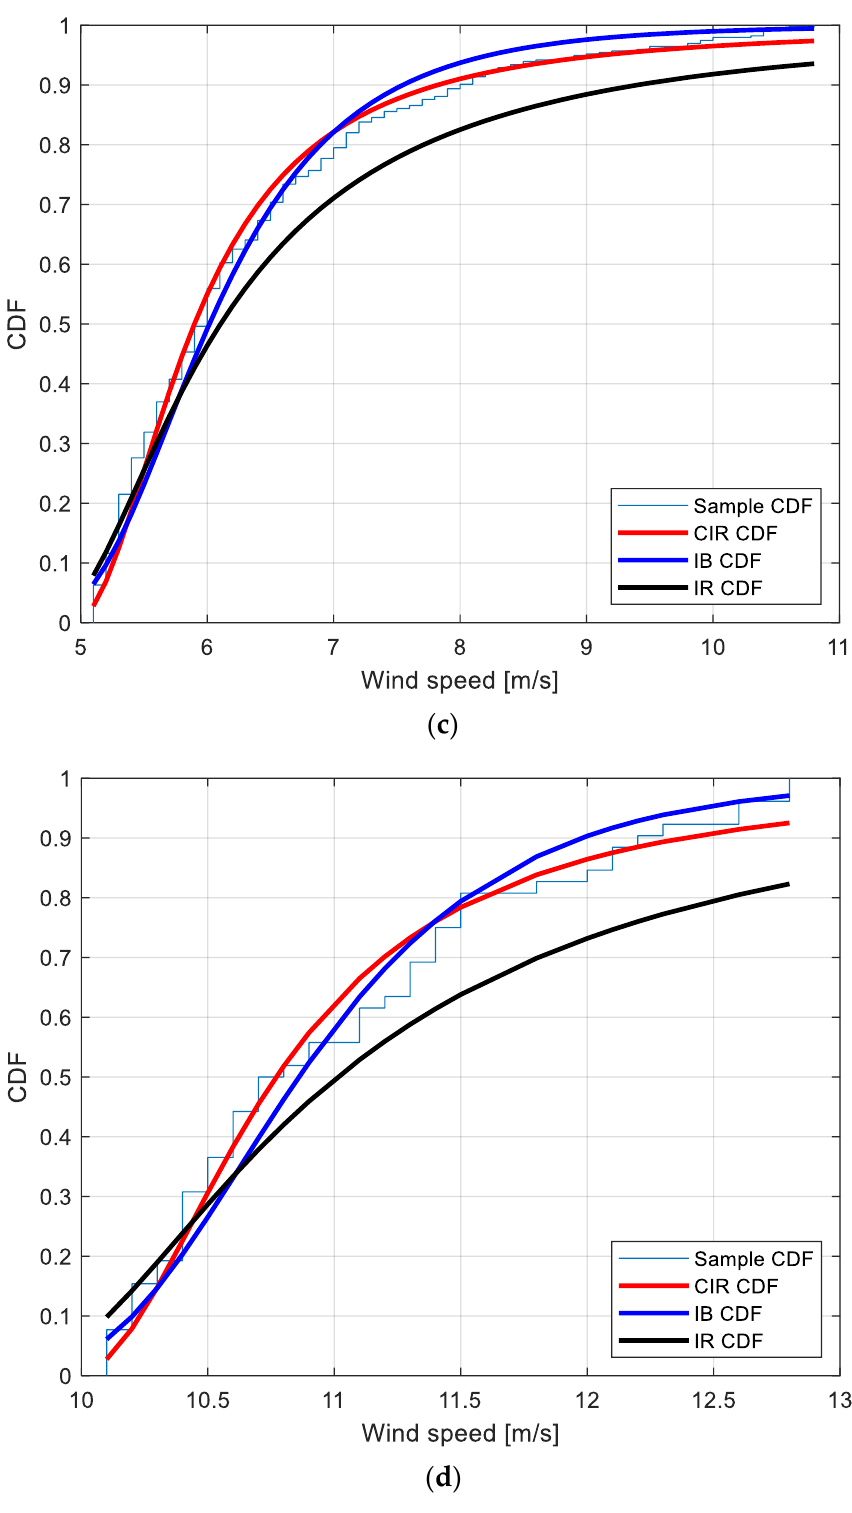
Figure 4. Sample CDF and fitted CIR, IB and IR distributions for the POT EWS at the locations: ( a ): Amintayo; ( b ): Beui; ( c ): Koilada; ( d ): Pontokomi.